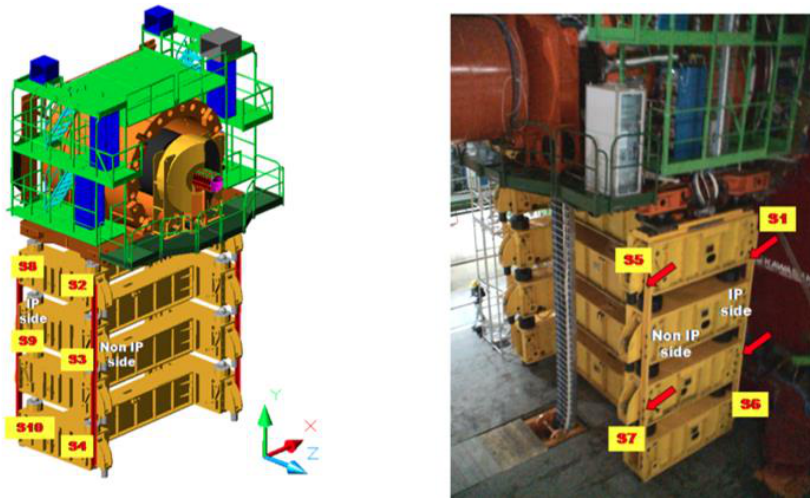
Figure 22. Layout of the FBG-based monitoring system installed on the HF raiser structure.